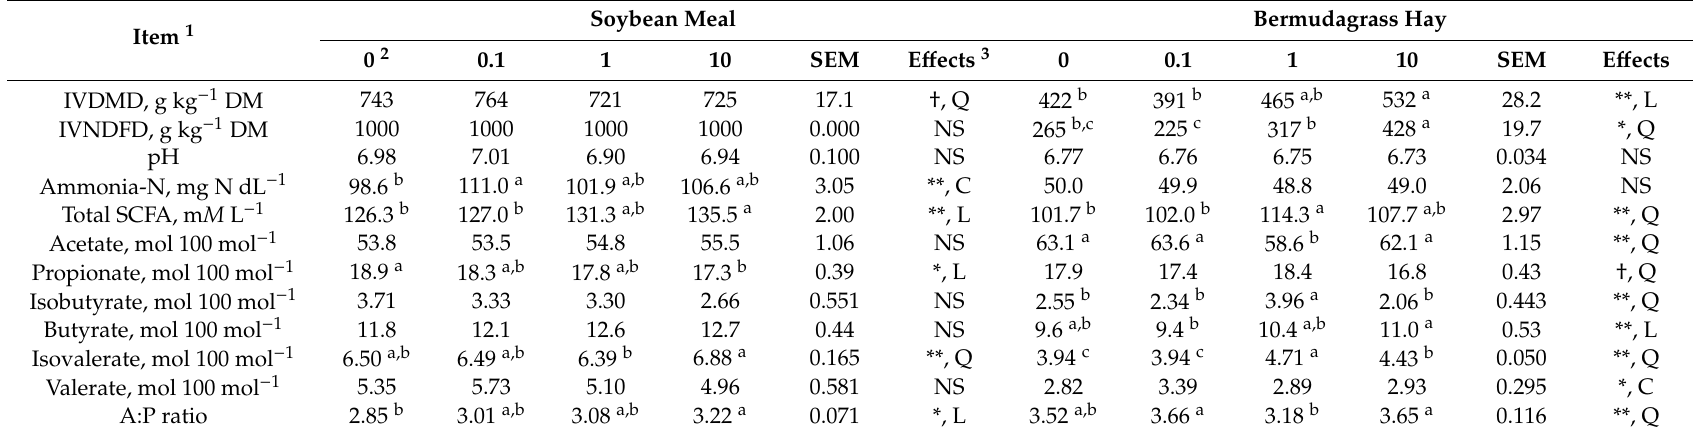
Table 4. E ff ects of San Wormwood Essential Oil Inclusion at Di ff erent Levels on In Vitro Digestibility and Fermentation Indices of Soybean Meal and Bermudagrass Hay after 72 h of Incubation in Bu ff ered Rumen